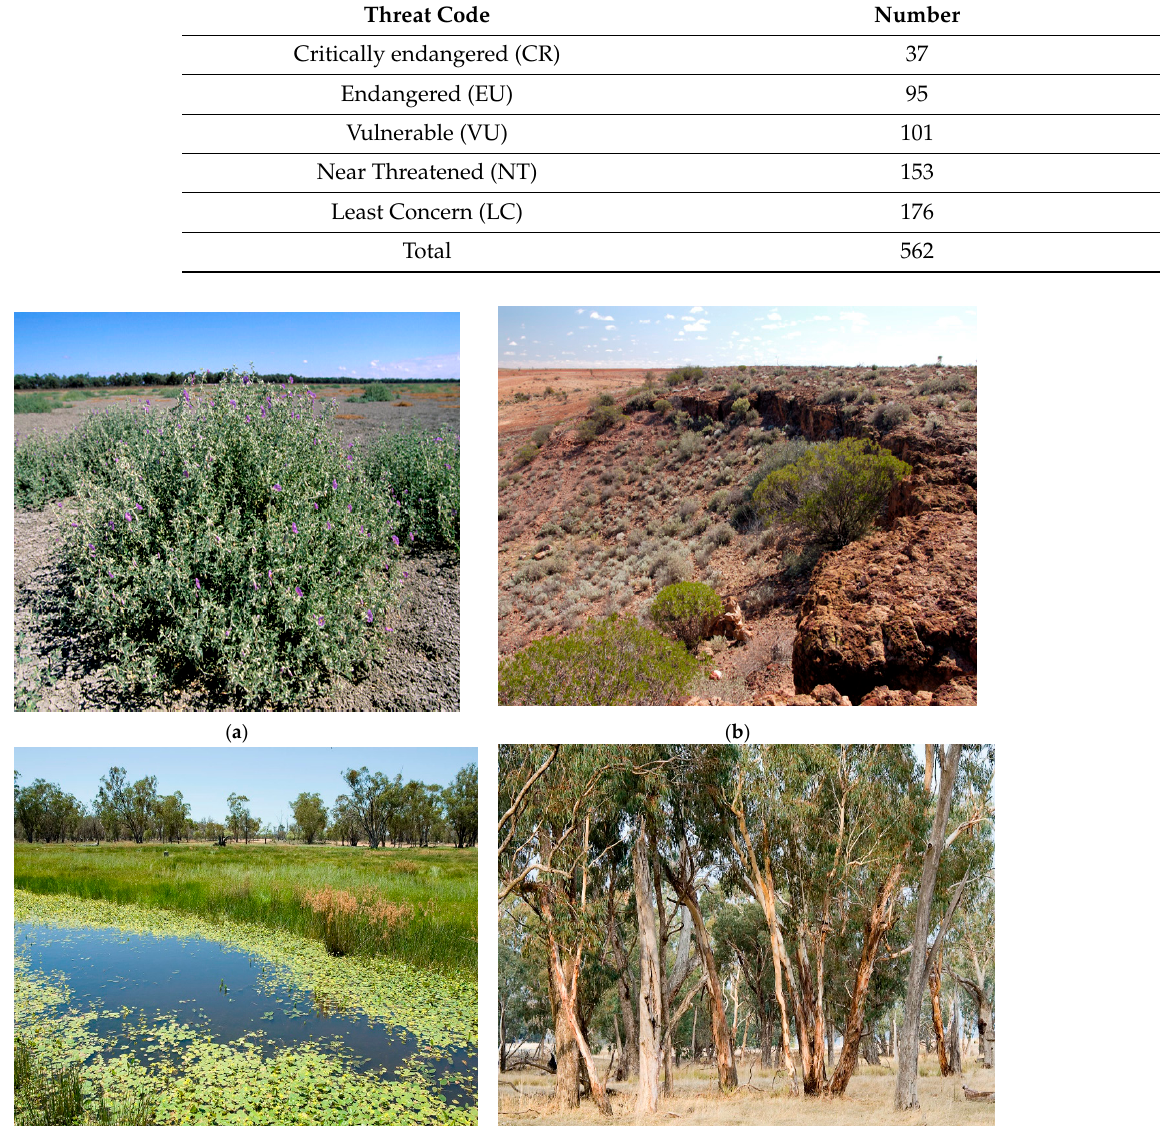
Table 1. Risk categories assigned to 562 inland NSW PCTs applying NSWVCA risk criteria outlined in Supplementary Materials S1 producing results in Supplementary Materials S2.